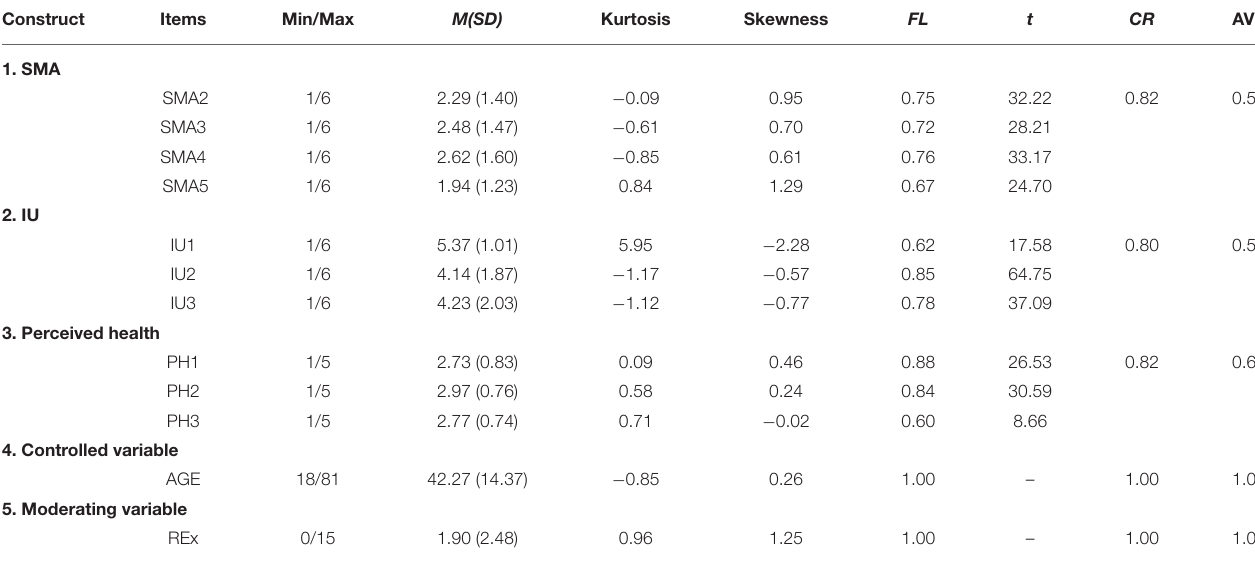
TABLE 4 | Construct reliability and validity analysis.